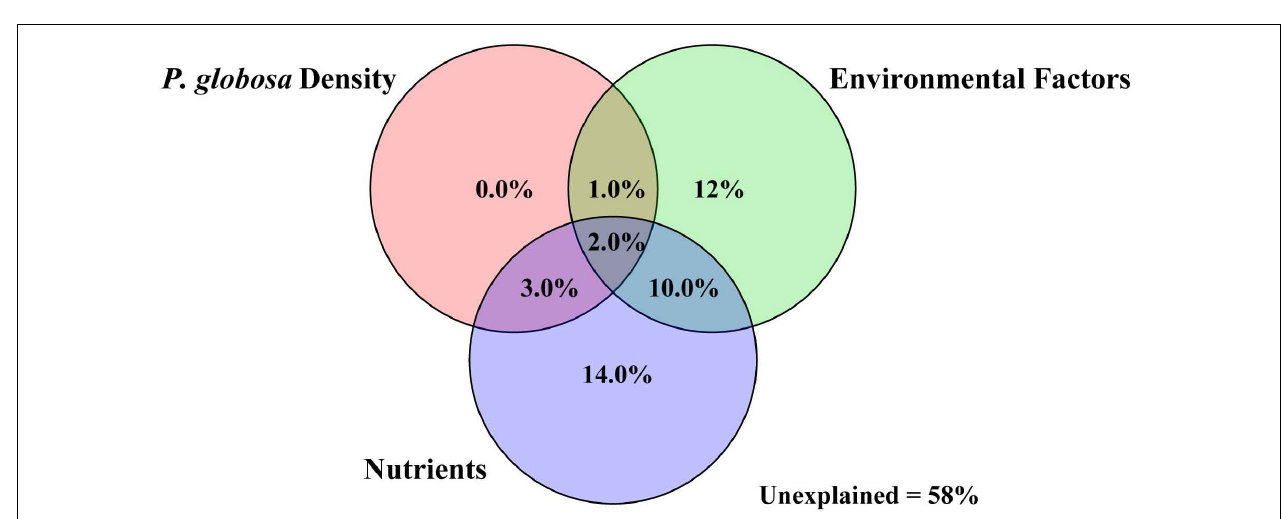
FIGURE 6 | Variation partitioning analysis of P. globosa density, environmental factors, and nutrients against bacterial community